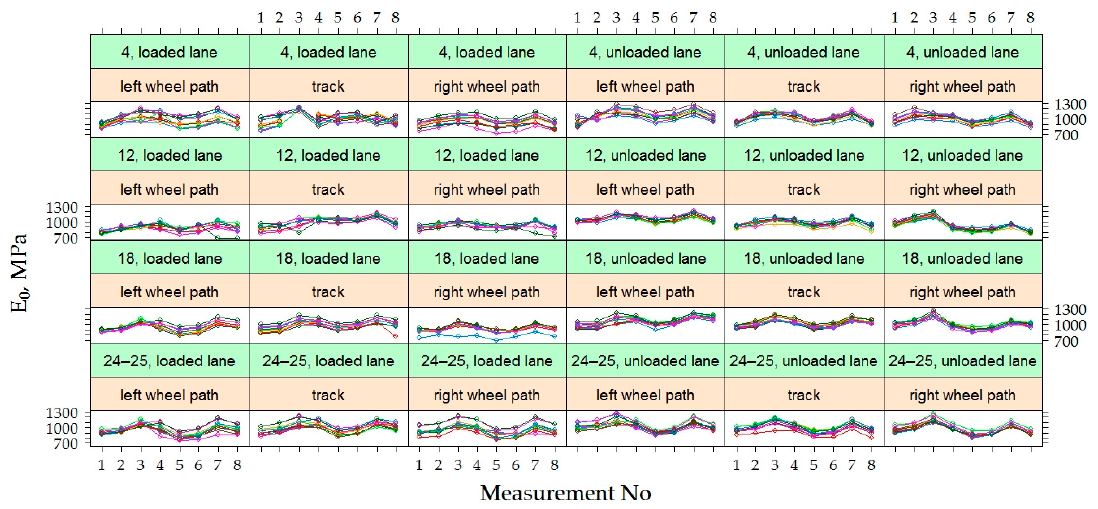
Figure 17. The dynamic of the individual E 0 values of each section for each point of measurement on the right and left wheel paths and in the loaded and unloaded lanes.